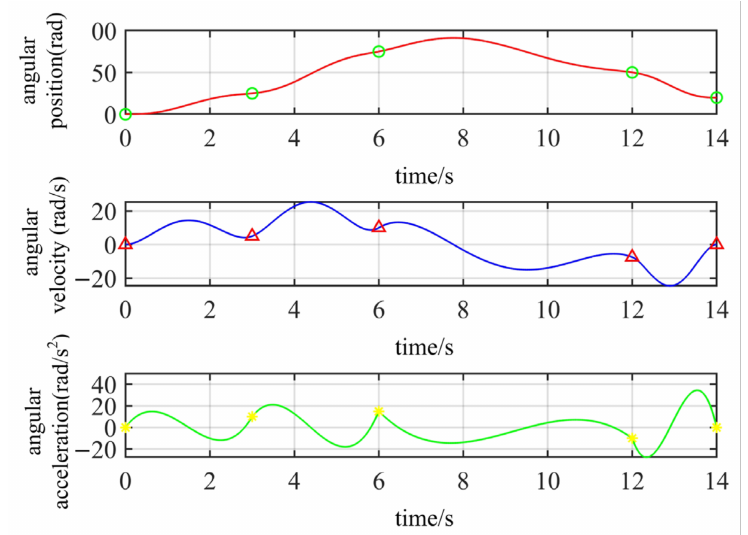
Figure 2. Quintic polynomial interpolation trajectory planning